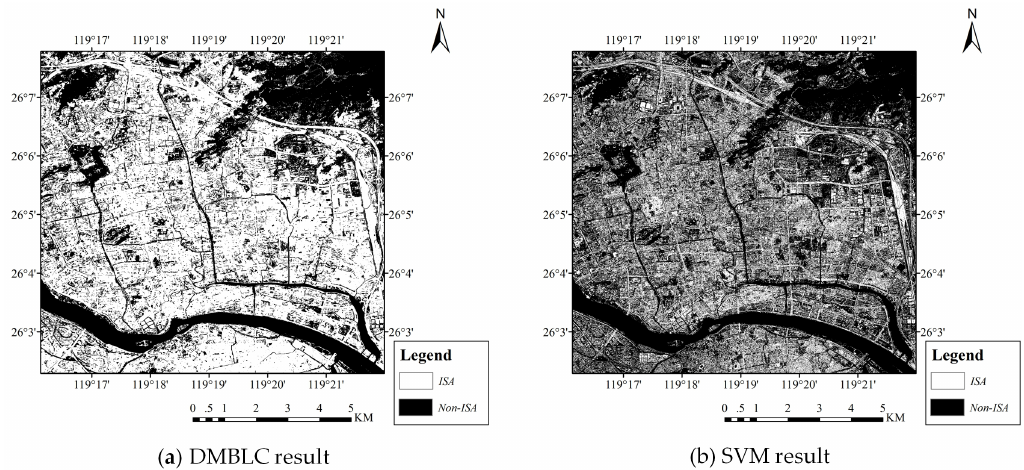
Figure 4. The ISA extraction result using: ( a ) the DMBLC; and ( b ) the support vector machines (SVM) method based on 0.6-m spatial resolution Google Earth images. Pixels in white indicate ISA, and pixels in black indicate